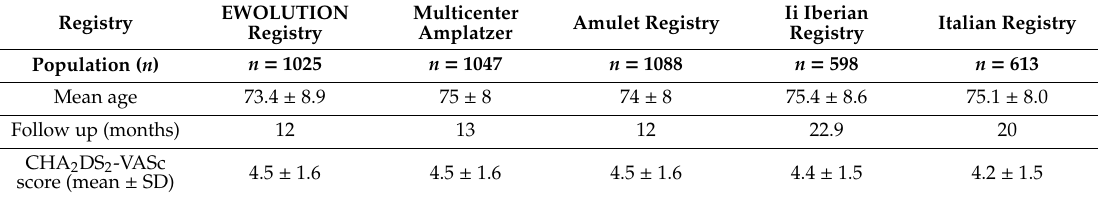
Table 6. Mean variables of patients with contraindication for OAC treatment reported in di ff erent